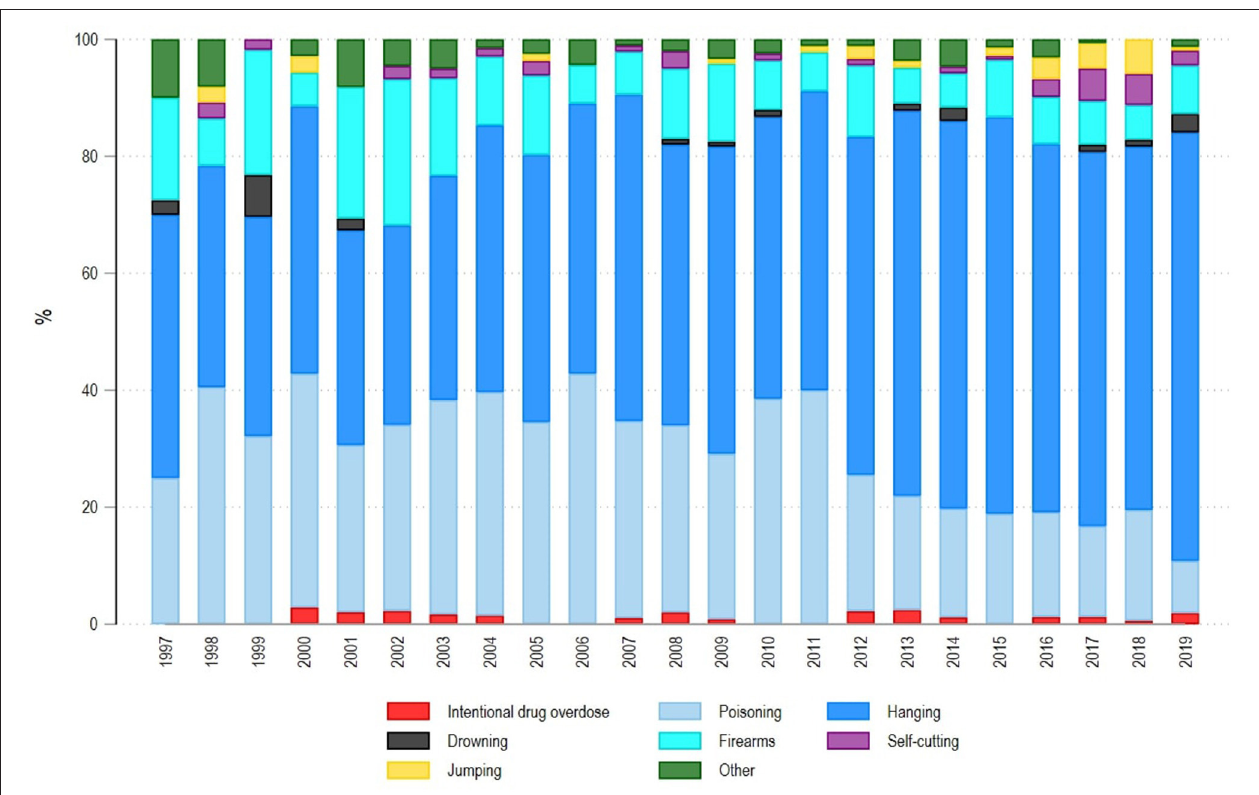
FIGURE 3 | Suicide rates by method among over 60-year-olds in Ecuador, 1997–2019.